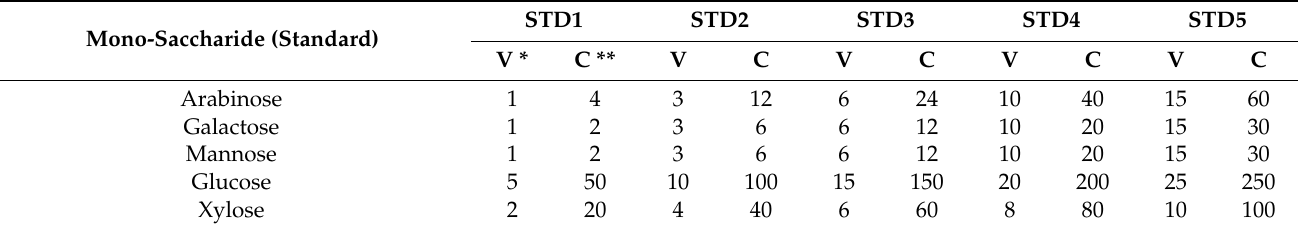
Table 2. Standard solutions for high-performance anion-exchange chromatography (HPAEC) measurements. STD1 Mono-Saccharide (Standard)